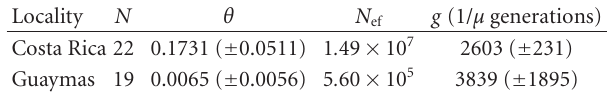
Table 1: E ff ective female population sizes ( N ef ) and exponential growth rates ( g ) in Junonia genoveva from Costa Rica and Guaymas, Mexico determined with